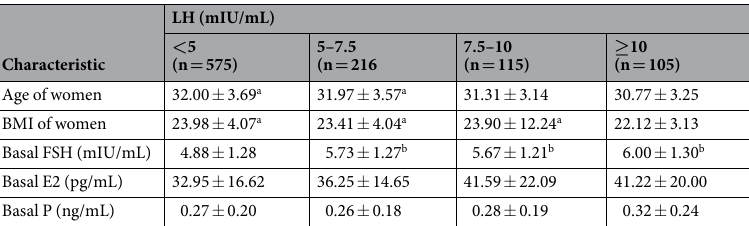
Table 1. Baseline patient characteristics. Data are presented as the mean ± SD. BMI: body mass index. a P < 0.05 vs. the group with LH ≥ 10 mIU/mL; b P < 0.05 vs. the group with LH < 5